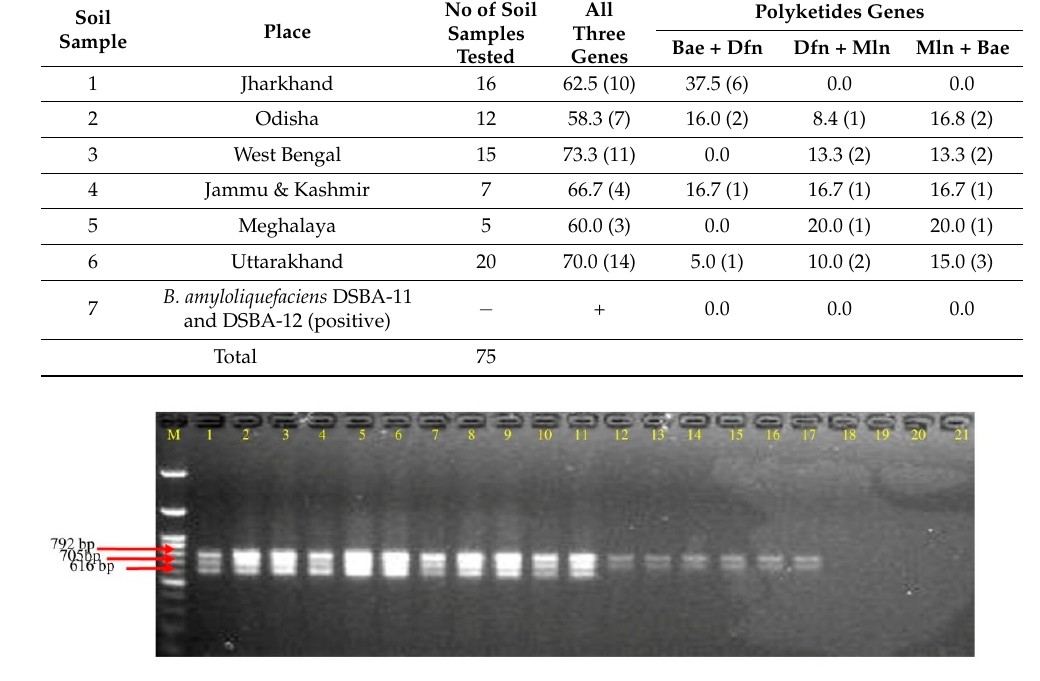
Table 2. List of soil DNA sample used for the detection of polyketides genes by multiplex-PCR. Table 3. Screening of polyketide antibiotics producing strains of Bacillus spp. isolated from rhizo- spheric soil of solanaceous Soil